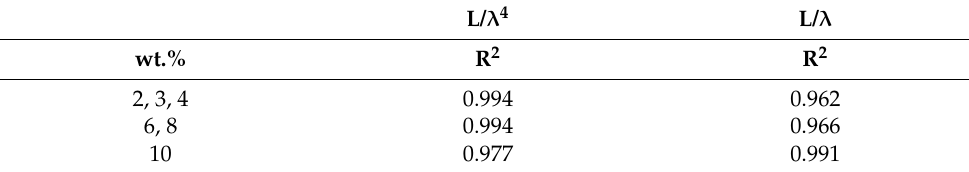
Table 2. Average adjusted R 2 values for the fitting of − Ln(T) as a function of L/ λ 4 or L/ λ .